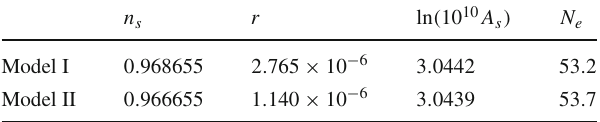
Table 1 The numerical results for the two